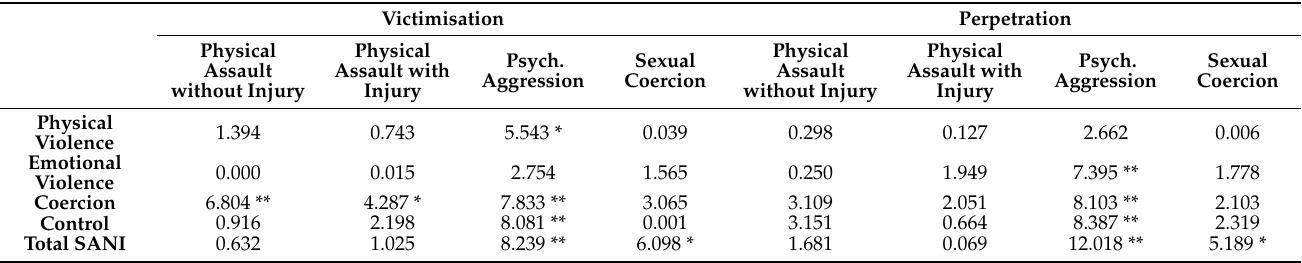
Table 3. Correlations between typology of abusive conflict-resolution tactics (CTS-2-R) and expo- sure/victimisation in family context